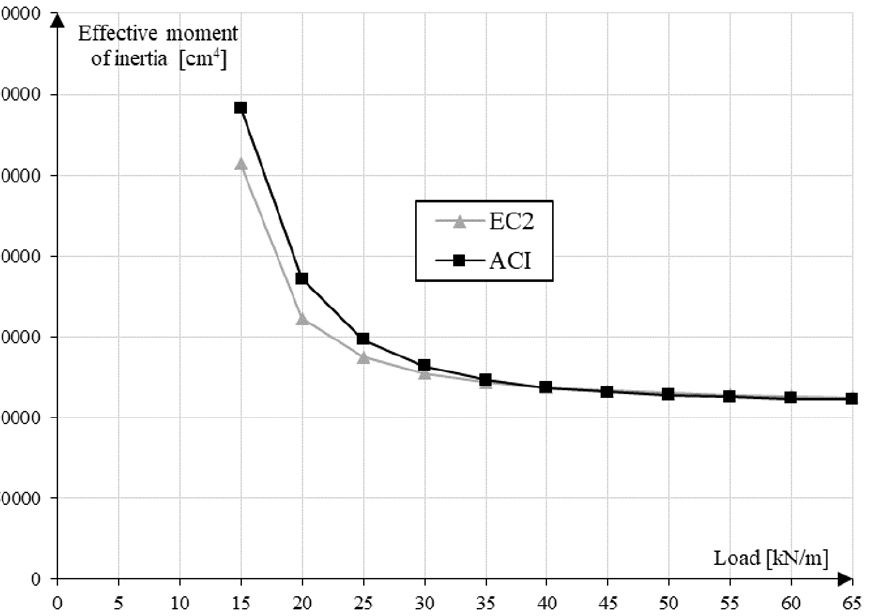
Figure 25: Values of effective moments of inertia according to, respectively, ACI Code 318-19 (2019) and EN 1992-1-1 (2004), depending on load in range of 15–65